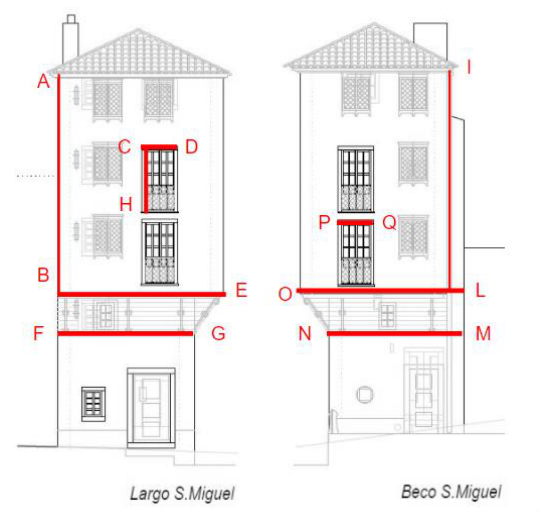
Figure 13. Case sudy No.2: Project drawing vectorized using the municipal building dossier (Dossier no. 21582).